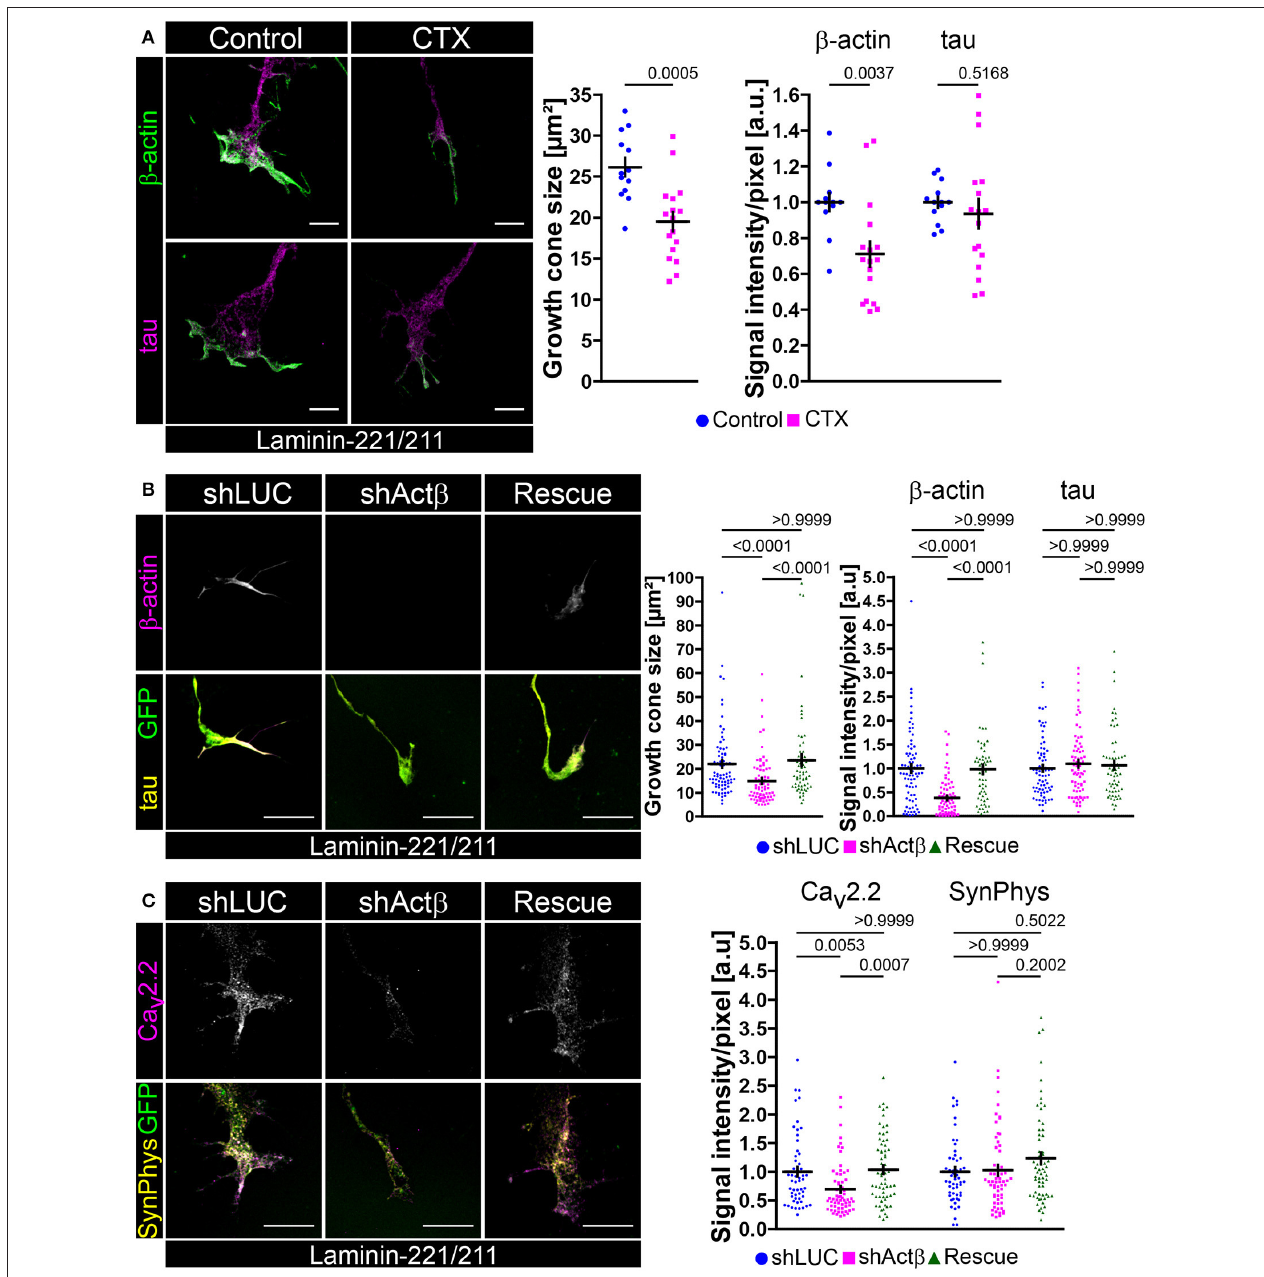
FIGURE 4 | Mutual regulation of neuronal excitability and β -actin presence in axonal growth cones of embryonic motoneurons on laminin-221. (A) Representative images of growth cones of embryonic motoneurons cultured on laminin-221/211 for 5 days in vitro with or without 30nM CTX and stained against β -actin (green) and tau (magenta) (scale bar: 5 µ m). CTX-treated motoneurons developed smaller growth cones (Control 26.14 ± 1.13 µ m 2 , Q 2 25.4 µ m 2 , n = 13, N = 226; 30nM CTX 19.51 ± 1.17 µ m 2 , Q 2 19.96 µ m 2 , n = 17, N = 274; p = 0.0005) with β -actin deficits (Control 1.00 ± 0.05, Q 2 1.00; 30nM CTX 0.71 ± 0.07, Q 2 0.68; p = 0.0037). Tau levels were comparable between both conditions. (B) Representative images of axonal growth cones of β -actin depleted and control motoneurons cultured on laminin-221/211 for 5 days in vitro and stained against β -actin (magenta) and tau (yellow) (scale bar: 5 µ m). Cells were selected by GFP expression (green) indicating successful lentiviral transduction. In comparison to shLUC-transduced control motoneurons β -actin shRNA-transduced cells revealed significantly smaller growth cones (shLUC 22.02 ± 1.68 µ m 2 , Q 2 16.89 µ m 2 , IQR 13.07 µ m 2 , N = 76; shAct β 14.85 ± 1.18 µ m 2 , Q 2 11.70 µ m 2 , IQR 11.45 µ m 2 , N = 74) and highly decreased β -actin signals (shLUC 1.00 ± 0.09, Q 2 0.90, IQR 0.92; shAct β 0.38 ± 0.05, Q 2 0.27, IQR 0.53). The microtubule cytoskeleton represented by tau appeared not affected. Re-expression of β -actin (“Rescue”) was able to rescue growth cone size (23.54 ± 2.44 µ m 2 , Q 2 17.09 µ m 2 , IQR 13.15 µ m 2 , N = 62) and β -actin immunoreactivity (0.98 ± 0.09, Q 2 0.96, IQR 0.82) validating the obtained β -actin based growth cone phenotype. (C) Representative images of β -actin depleted growth cones on laminin-221/211 stained against Ca v 2.2 (magenta) and synaptophysin (yellow) (scale bar: 5 µ m). Knockdown of β -actin resulted in reduced Ca v 2.2 signals (shLUC 1.00 ± 0.09, Q 2 0.84, IQR 0.75, N = 54; shAct β 0.70 ± 0.06, Q 2 0.52, IQR 0.46, N = 63), whereas synaptophysin levels were not altered. Re-entry of β -actin was able to rescue the detected phenotype (Rescue 1.04 ± 0.07, Q 2 1.05, IQR 0.90, N =